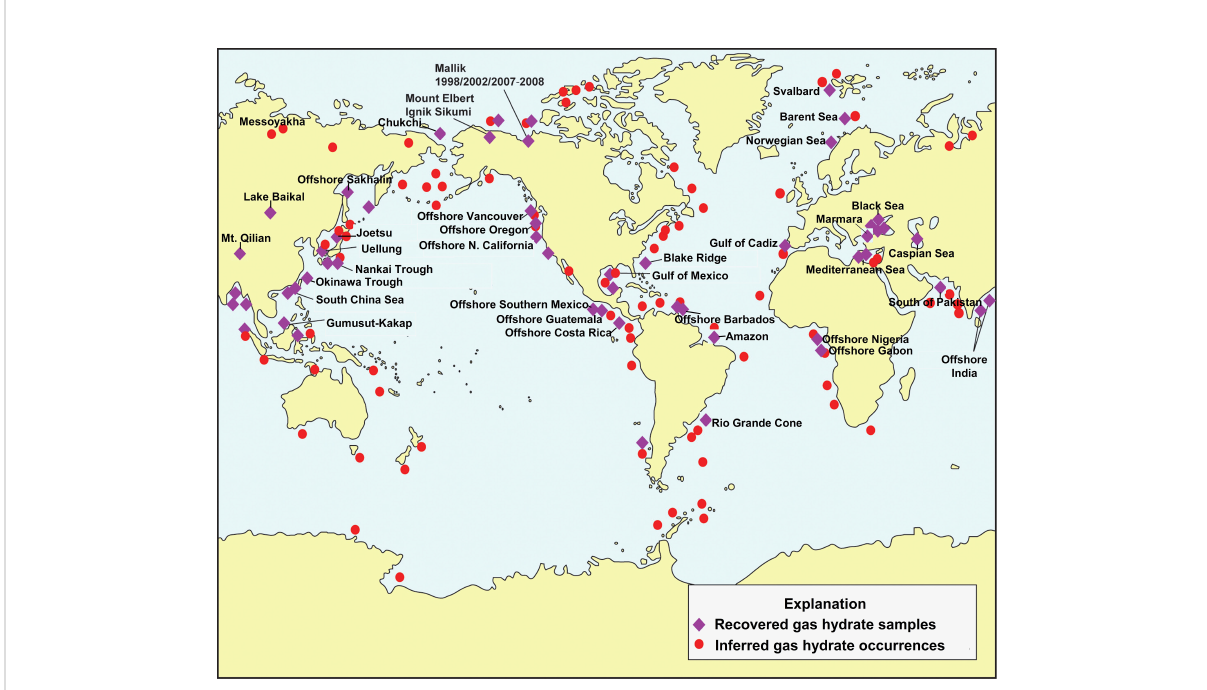
FIGURE 3 Location of sampled and inferred methane hydrate occurrences in marine sediment of outer continental margins and permafrost regions, modi fi ed from (Collett et al., 2009). Data of samples adopted in this study are highlighted with site name on this